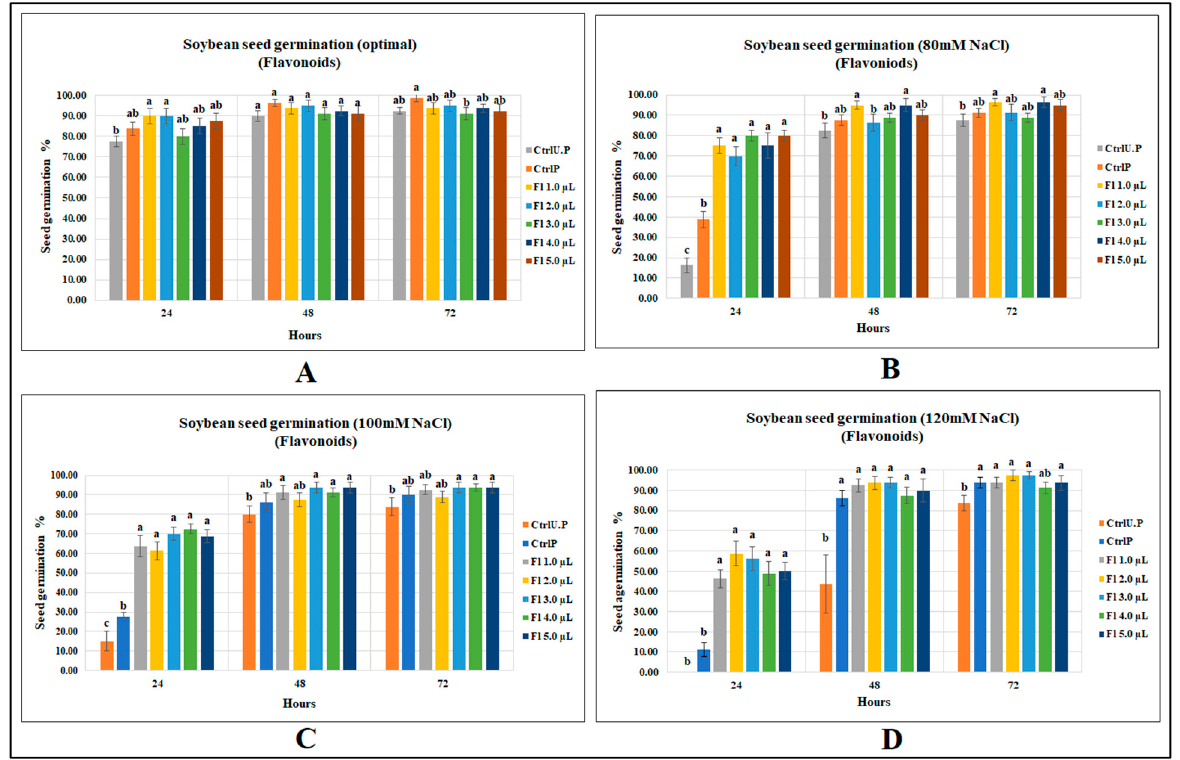
Figure 2. Flavopriming and seed germination of soybean: ( A ) optimal growth conditions, ( B ) 80 mM NaCl, ( C ) 100 mM NaCl, ( D ) 120 mM NaCl . Data shown as mean ± SE of 8 biological replicates; different letters indicate values determined by Tukey’s multiple mean comparison to be significantly different ( p < 0.05) among treatments.